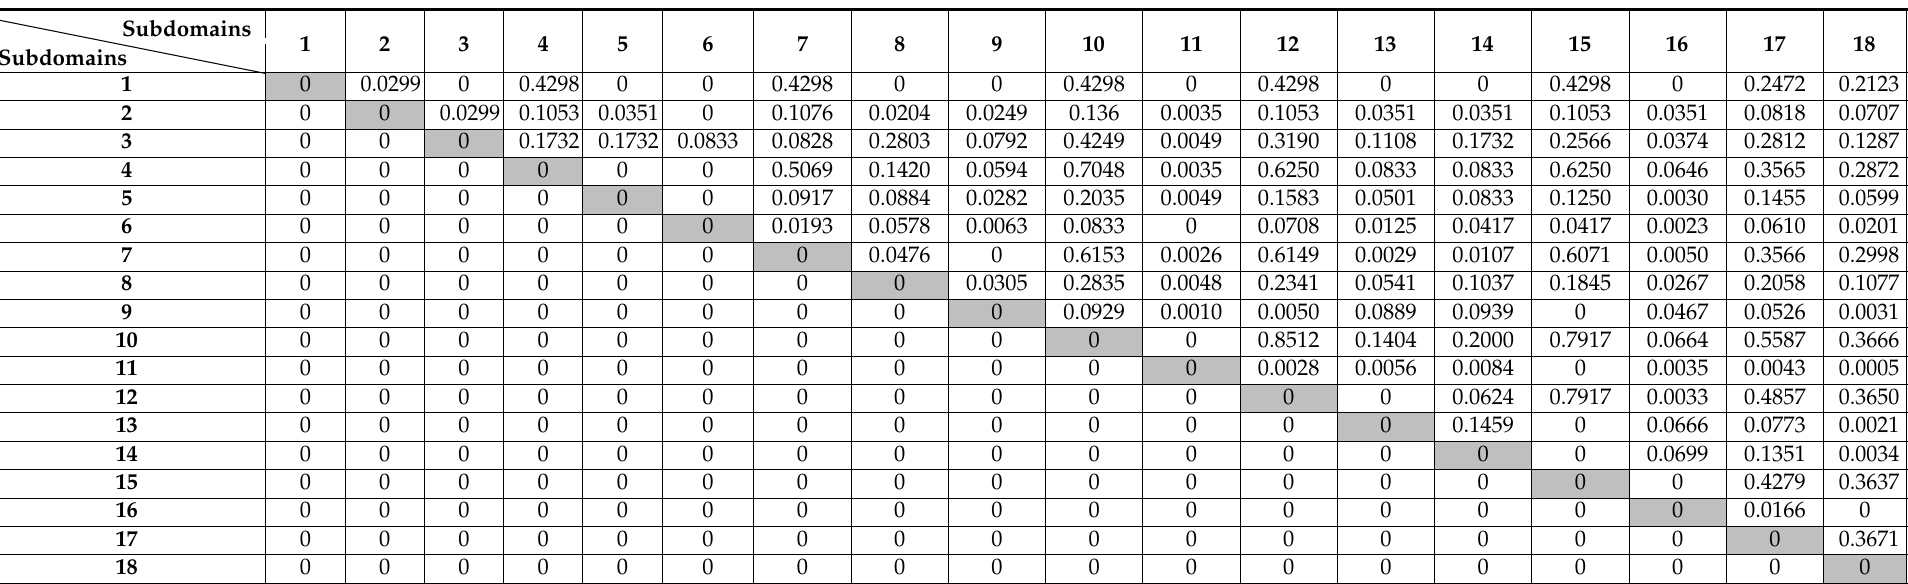
Table 17. Use-case Intersection Triangular Top Matrix (ITTM) for CO 2 sensor fault (The background color is the boundary of the upper triangular